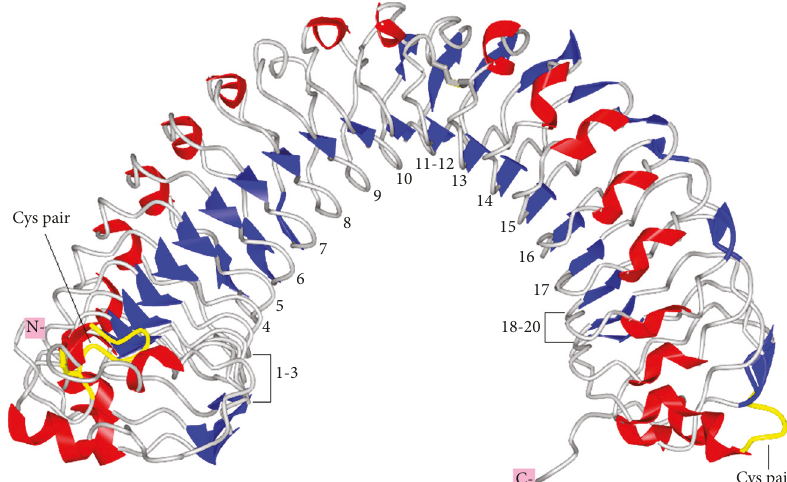
Figure 3: The 3D structure of RLK7 extracellular domain. The model was generated using a multiple-template modeling approach (HHpred) [39]. The β -sheets are shown in blue, α -helices in red, and cysteine pairs in yellow. The LRRs are numbered/marked with the numbers from 1 to 20. “N” and “C” denote the amino and carboxy terminus,